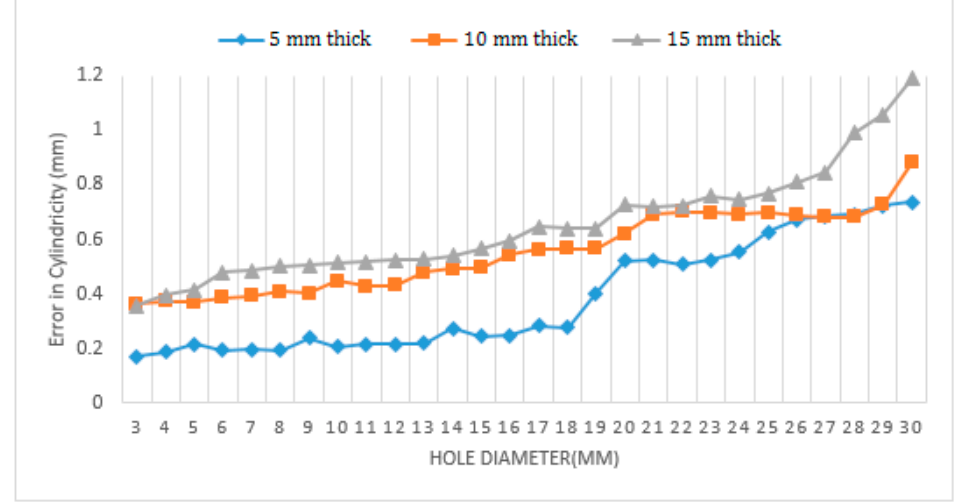
Figure 14. Cylindricity of holes fabricated without support.